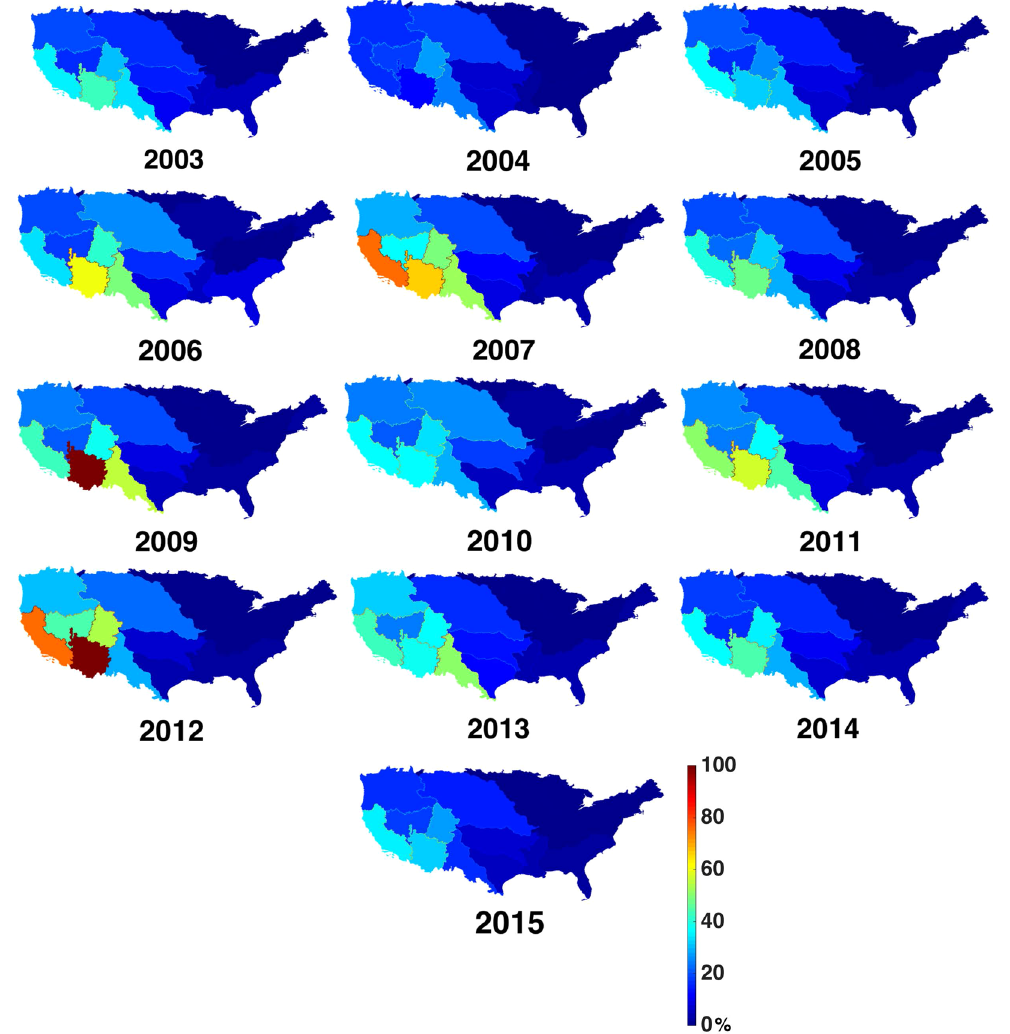
Figure 3. Annual 2003–2015 percent consumptive water use to availability ratios for the 18 two-digit HUC regions of the continental United States. Values shown represent results obtained when median environmental coefficient and irrigation efficiency parameters were used (created using Matlab version 2015b: https://www.